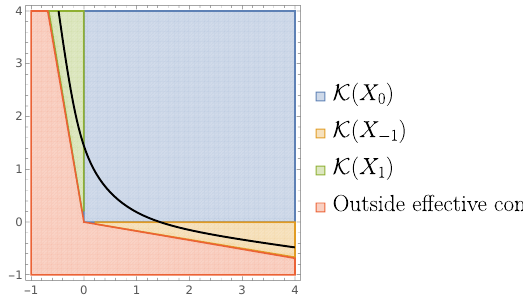
Figure 7 . Effective cone of CICY #7863, showing Kähler cone of CY X , with infinitely many adjacent Kähler cones of isomorphic CYs (only two of which can be resolved), with a geodesic curve superimposed. The boundaries of the extended Kähler cone are generated by ( − 1 , 3 + 2 √ (3 + 2 2 , − 1)